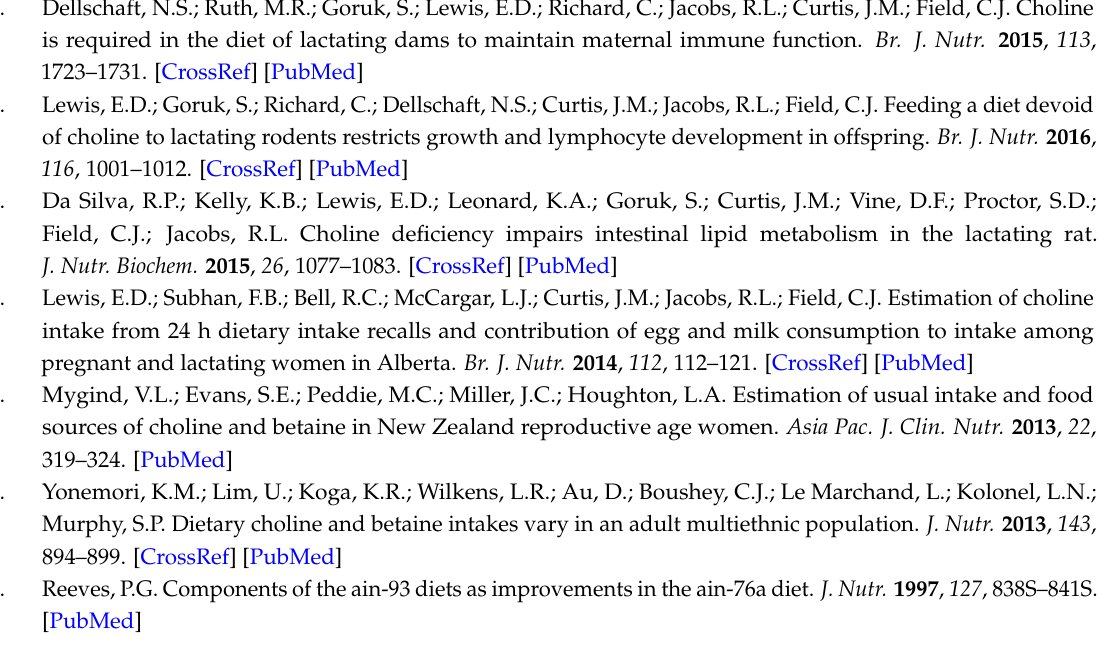
Table S1: Fatty acid composition of experimental diets; Table S2: Total choline content and relative contribution of the different forms of choline in the stomach contents of offspring at 3 weeks of age from lactating dams fed Control (100% FC), Mixed Choline (MC; 50% PC, 25% FC, 25% GPC) or High GPC (HGPC; 75% GPC, 12.5% PC, 12.5% FC) diets; Table S3: Total number of T and B lymphocyte populations in the spleen and mesenteric lymph nodes of lactating dams fed Control (100% FC), Mixed Choline (MC; 50% PC, 25% FC, 25% GPC) or High GPC (HGPC; 75% GPC, 12.5% PC, 12.5% FC) diets; Table S4: Cytokine production by mesenteric lymphocytes after ex vivo stimulation with LPS from lactating dams fed Control (100% FC), Mixed Choline (MC; 50% PC, 25% FC, 25% GPC) or High GPC (HGPC; 75% GPC, 12.5% PC, 12.5% FC) diets; Figure S1: IL-2 production by splenocytes after ex vivo stimulation with Concanavalin A (ConA) from lactating dams fed Control (100% FC), Mixed Choline (MC; 50% PC, 25% FC, 25% GPC) or High GPC (HGPC; 75% GPC, 12.5% PC, 12.5% FC)